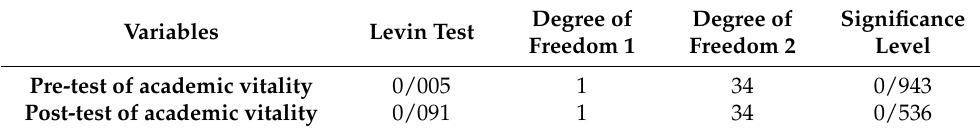
Table 8. Levin test for assessing the homogeneity of variances of academic vitality variables. Variables